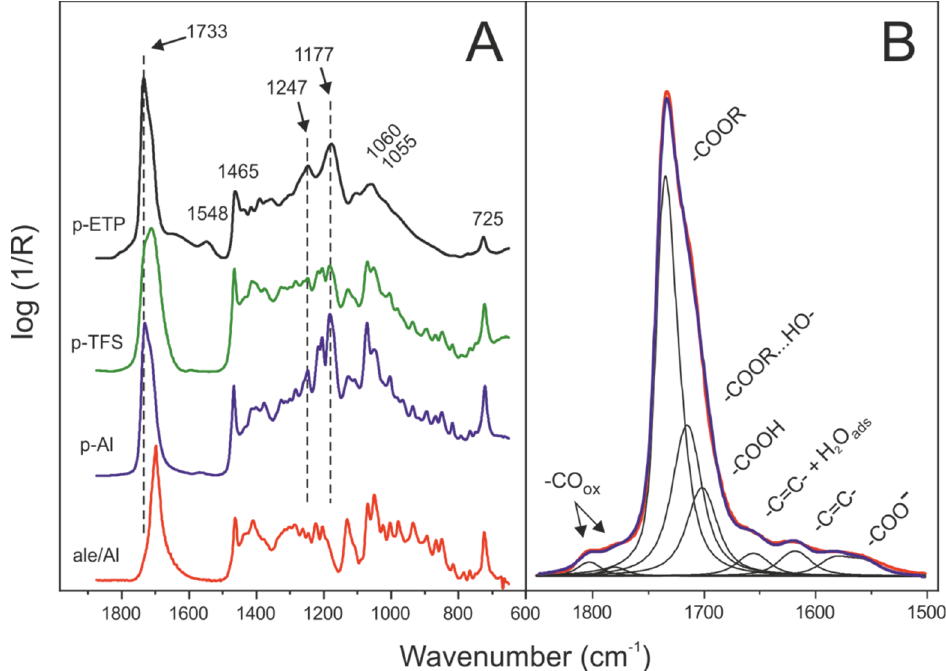
Figure 3. ( A ) Comparative specular reflectance FTIR spectra in the 1875–650 cm − 1 region of a polyaleuritate film formed on Al (p-Al), TFS (p-TFS) and ETP (p-ETP) substrates at 200 °C for 10 min in air. As a reference, the spectrum of a film of unreacted aleuritic acid on Al (ale/Al) is included. ( B ) Component bands and assignations used for the qualitative and quantitative analyses of specular reflectance FTIR data of polyaleuritate coatings.